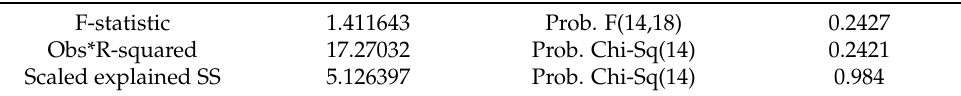
Table A5. Heteroskedasticity Test: